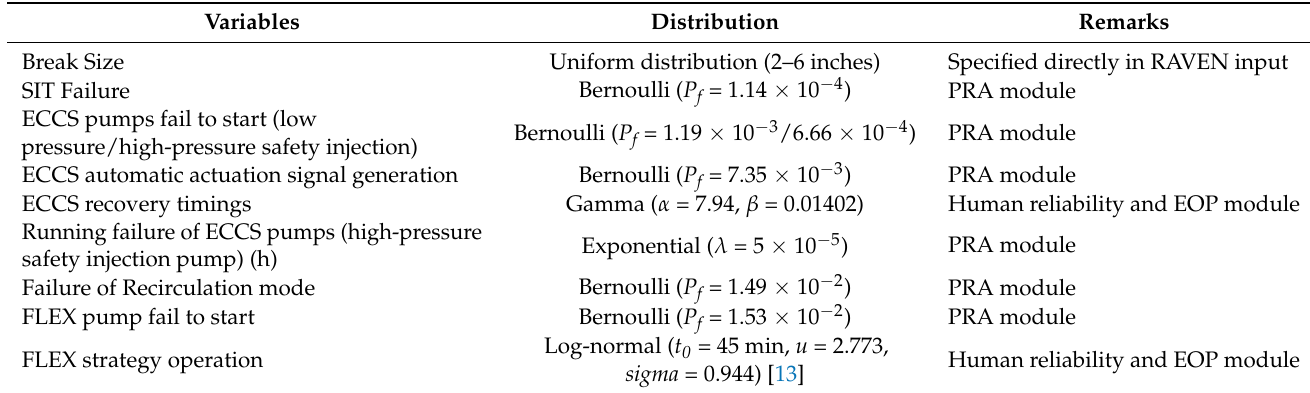
Table 4. Selected variable with